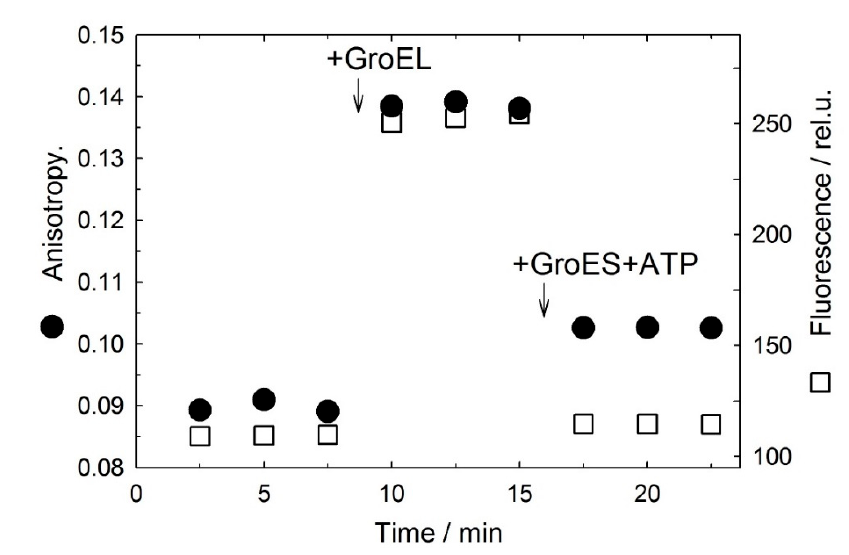
Figure 6. Kinetics of denatured FAM- α -lactalbumin fl uorescence intensity at 520 nm ( □ ) and anisotropy ( ● ) changes after successive addition of GroEL and GroES+ATP (shown by arrows).